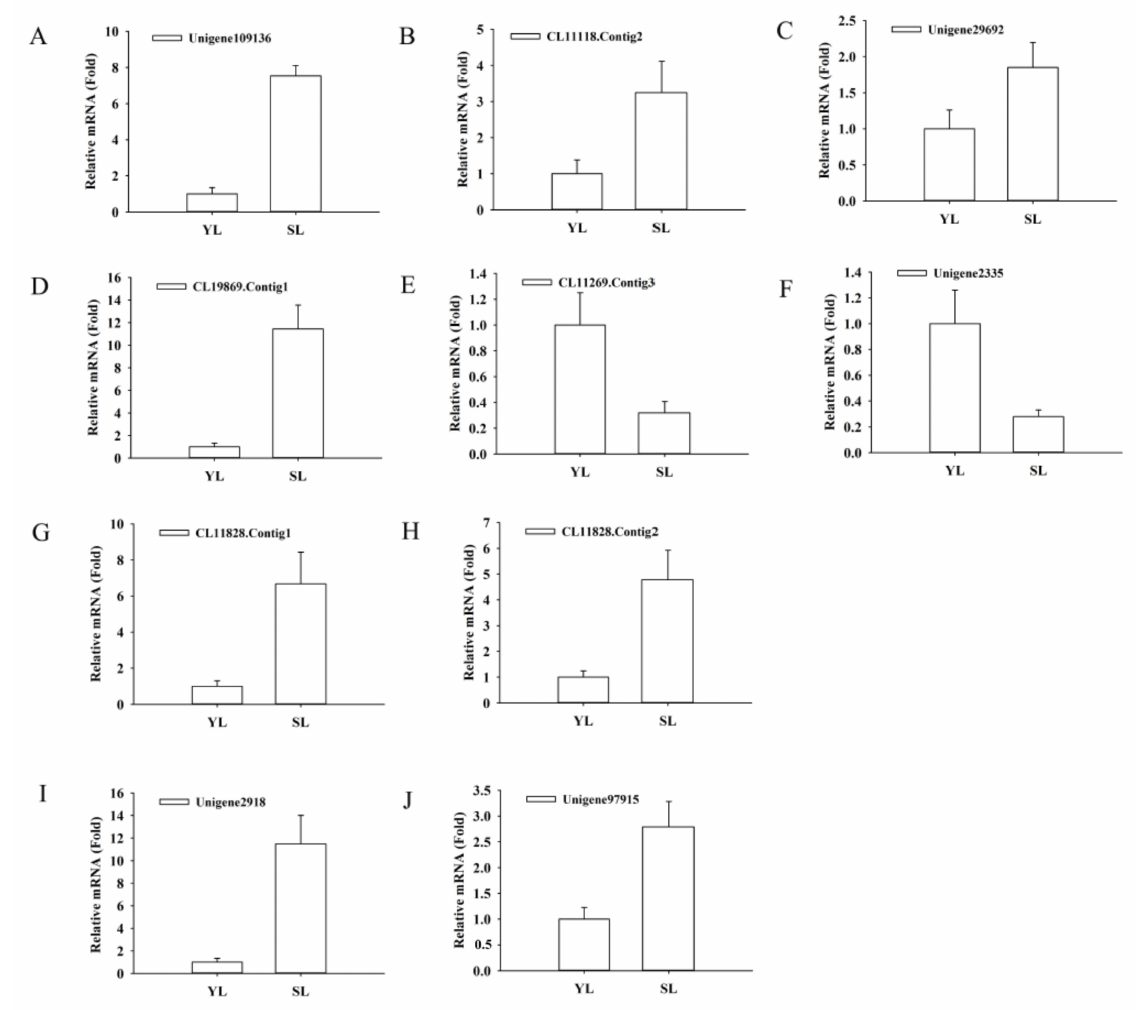
Figure 5. Expression patterns of selected unigenes related to luteoloside biosynthesis identified by RNA-Seq were validated by qRT-PCR. Expressions of unigenes located upstream of luteoloside metabolic pathway ( A ) Unigene109136 ( PAL ), ( B ) CL11118.Contig2 ( C4H ), ( C ) Unigene29692 ( 4CL ) and downstream of luteoloside metabolic pathway ( D ) CL11269.Contig3 ( CHI ), ( E ) CL19869.Contig1 ( CHS ), ( F ) Unigene2335 ( FNSII ), ( G ) CL11828.Contig1 and ( H ) CL11828.Contig2 ( F3’H ), ( I ) Unigene2918 and ( J ) Unigene97915 ( UFGT ) in young and senescing leaves were analyzed by qRT-PCR. Relative expression levels were determined based on the reference young leaves set to 1. Values are means ± SD of three biological repetitions ( n = 3). Two technical replicates for each biological replicate were performed in each qRT-PCR